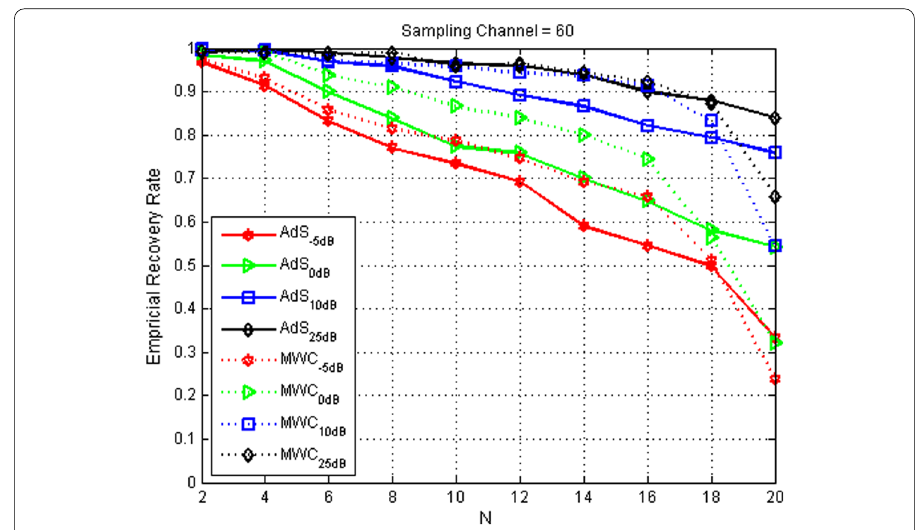
Fig. 12 Percentage of correct support recovery, when SNR